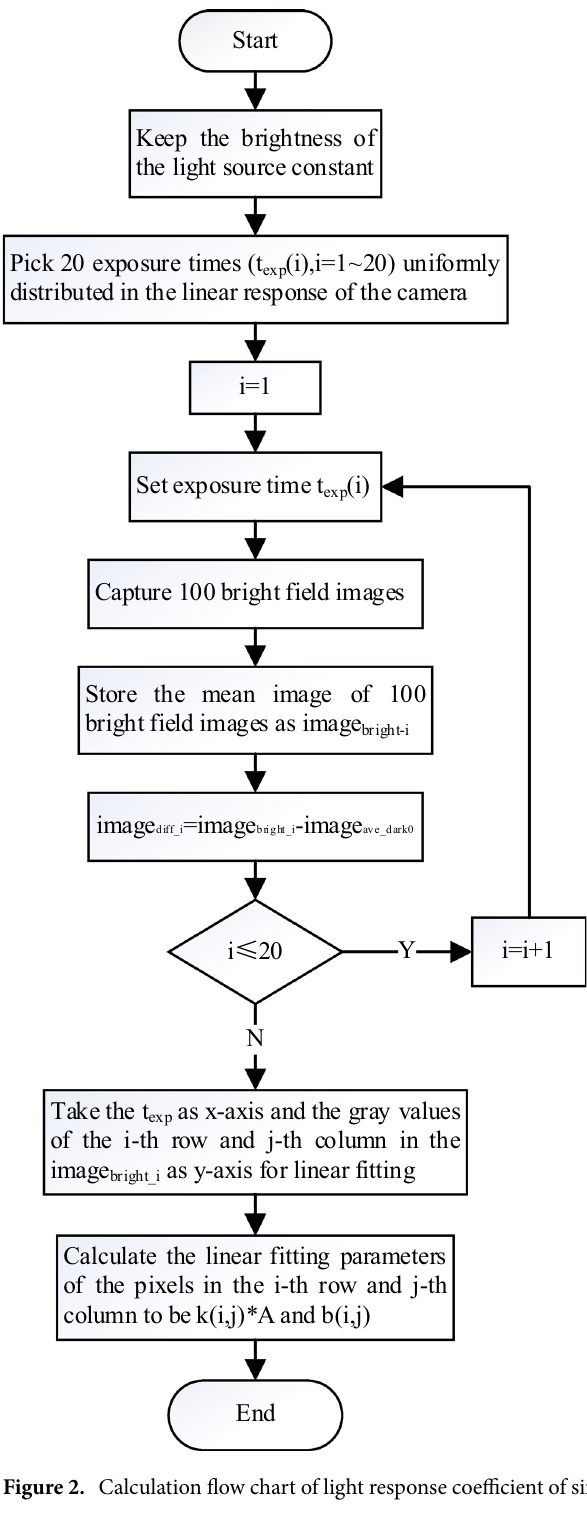
Figure 2. Calculation flow chart of light response coefficient of single